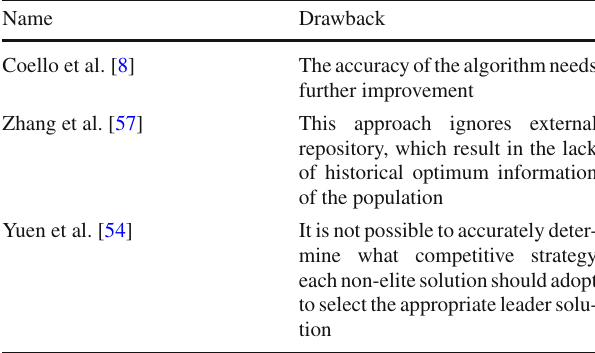
Table 3 MOPSO algorithm and variants and their